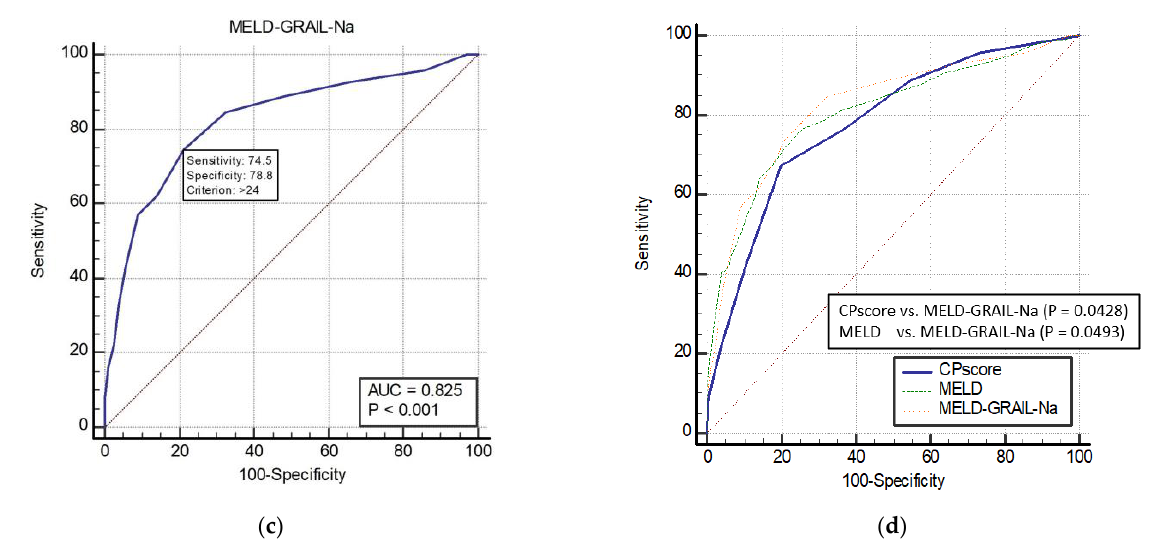
Figure 3. Receiver operating characteristic curves (ROC) and area under the ROC (AUROC) of patients with CP classes B and C for 1 - month mortality. ( a ) CP score for 1 - month mortality, 0.782 (95% CI, 0.753–0.809), ( b ) MELD for 1 - month mortality, 0.809 (95% CI, 0.781–0.834); ( c ) MELD - GRAIL - Na for 1 - month mortality, 0.825 (95% CI, 0.798–0.850); ( d ) comparison of AUROC for 1 - month mortality between the CP, MELD, and MELD - GRAIL - Na scores.